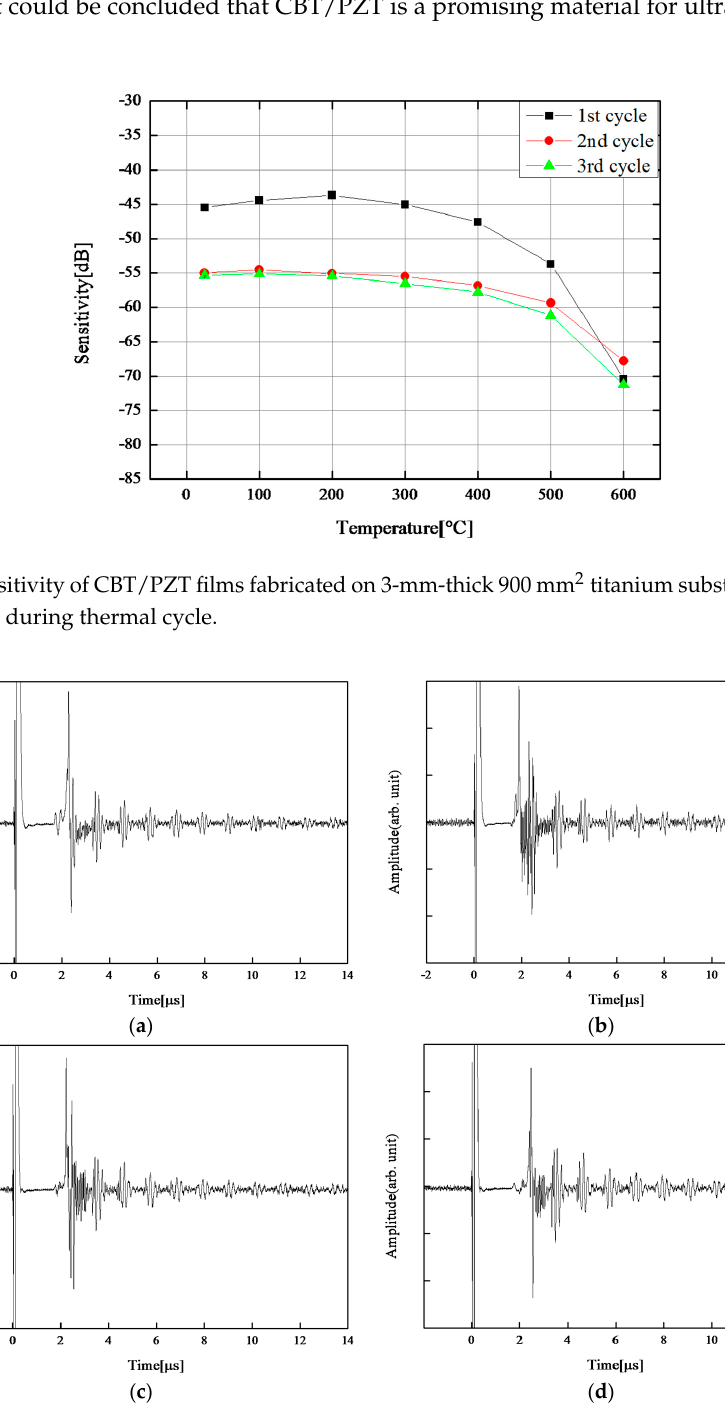
Figure 6. Ultrasonic measurement result of CBT/PZT films fabricated on 3-mm-thick 900 mm 2 titanium substrate at 600 °C after ( a ) 0 h, ( b ) 6 h, ( c ) 24 h, and ( d ) 36 h.